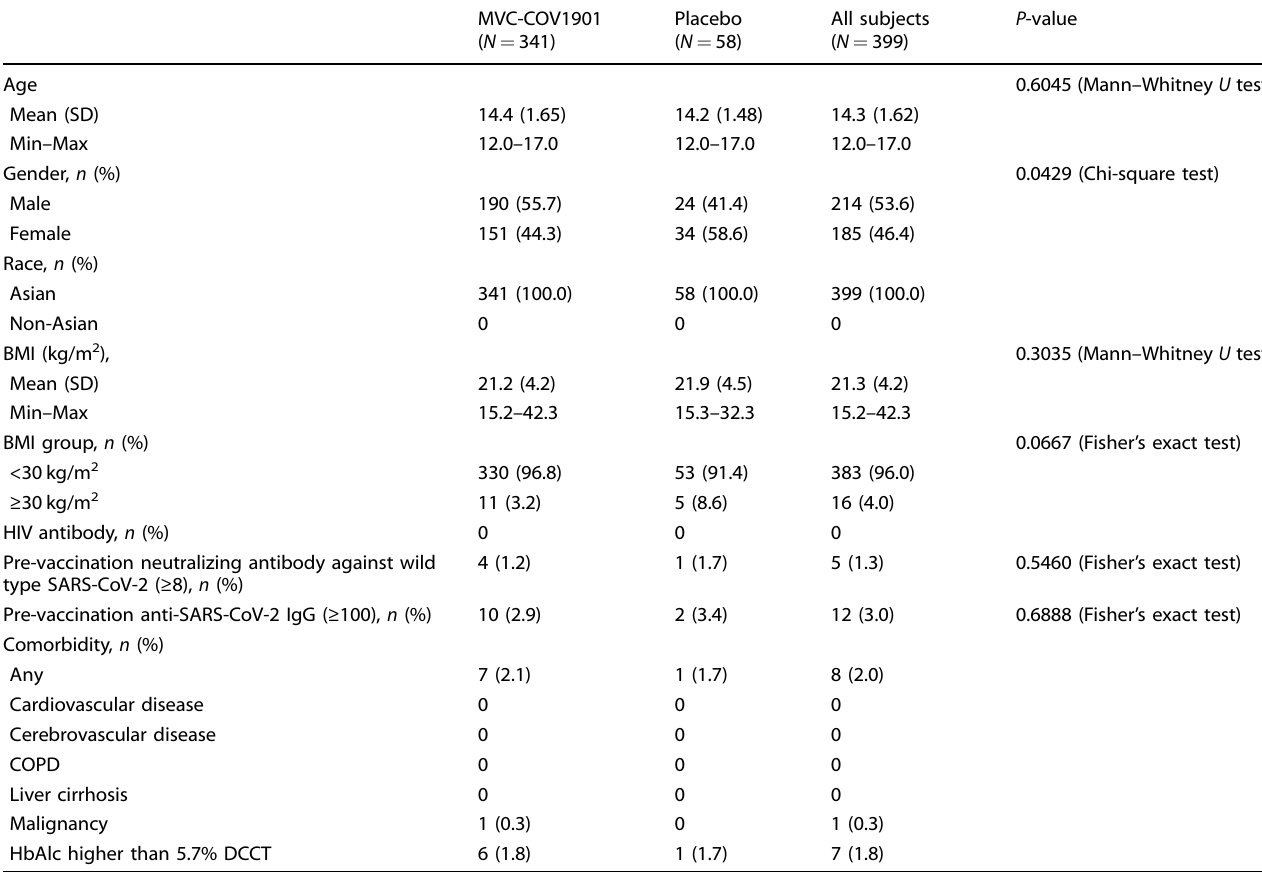
Table 1. Summary of demographics of the participants who received study intervention (safety